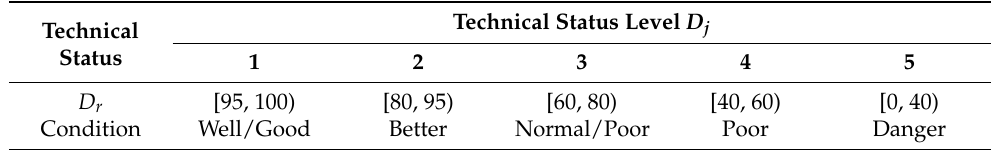
Table 3. Bridge Technical Condition Classification Limit.